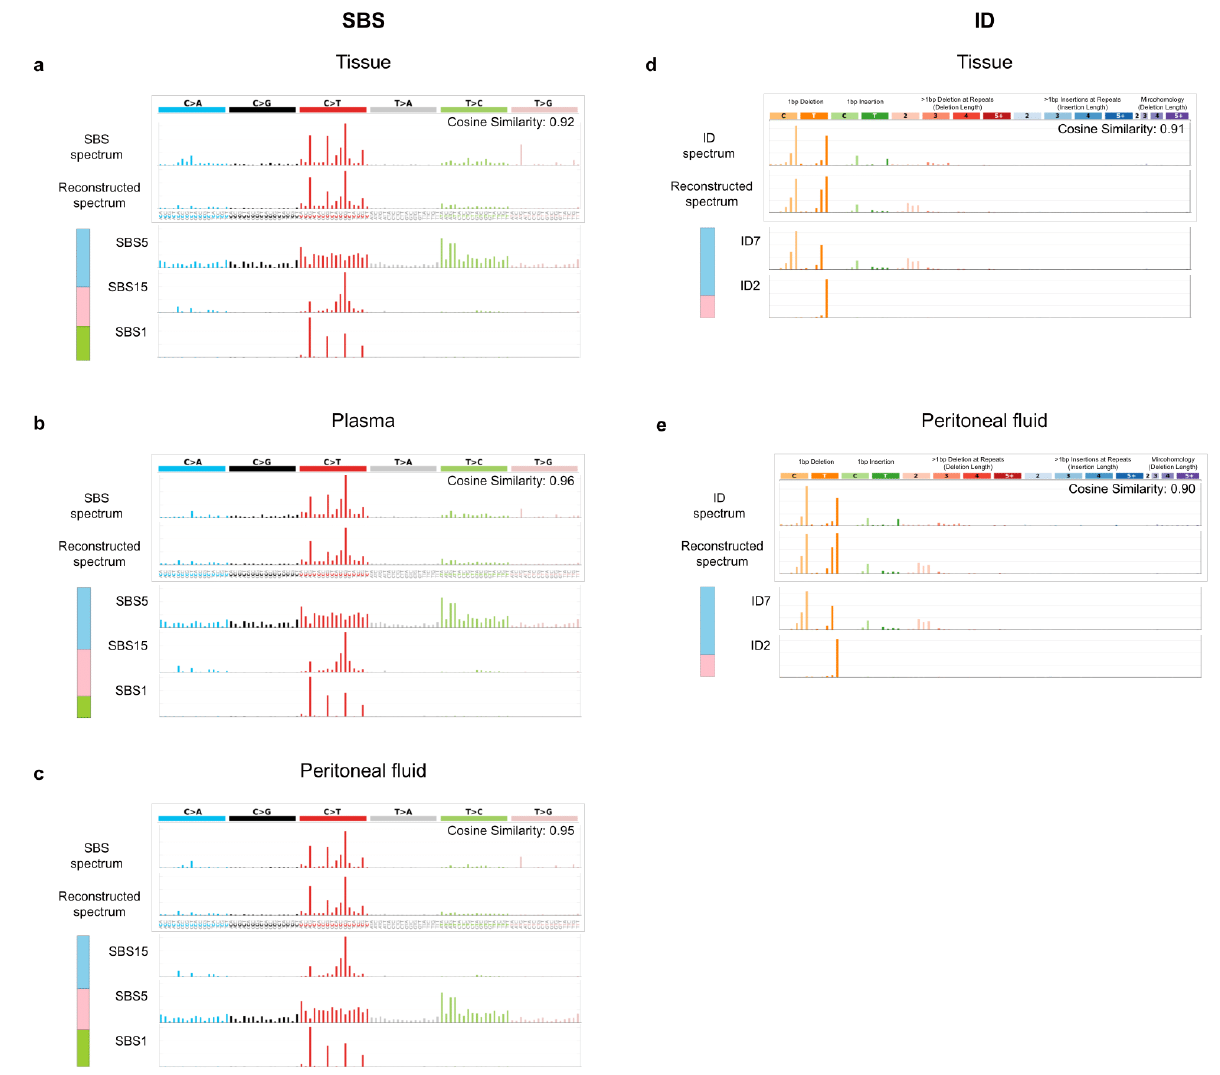
Figure 5. Mutational signatures in EC. ( a – c ) SBS and ( d , e ) ID from the COSMIC database identified in tissue, plasma, and peritoneal fluid of EC patients are indicated (cosine similarity ≥ 0.9). Bar plot indicates the proportion of each signature. Abbreviation: SBS, single-base-substitution; ID, small insertion-and-deletion.